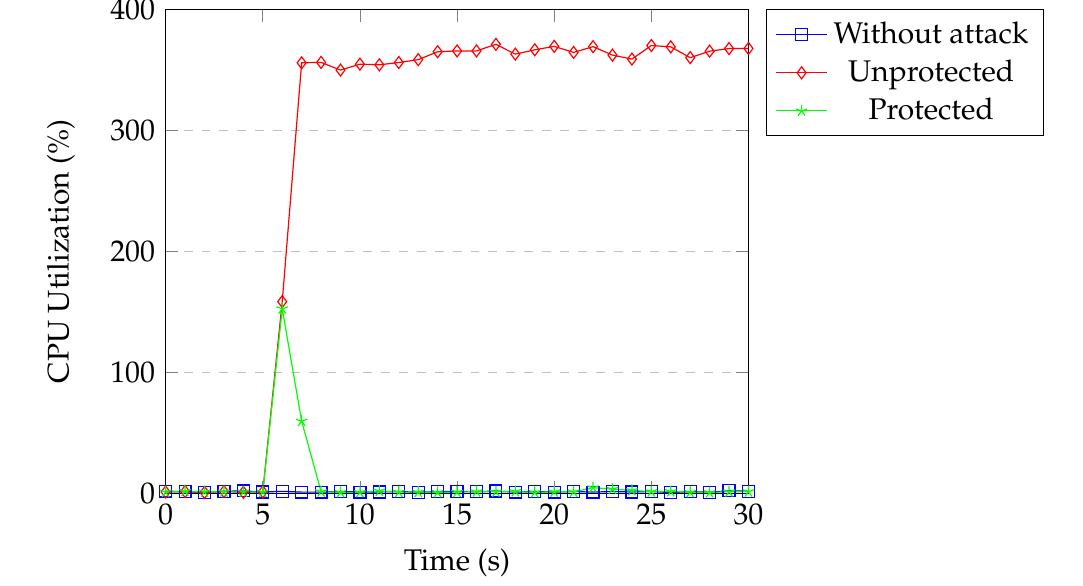
Figure 24. Switch CPU under UDP flood.